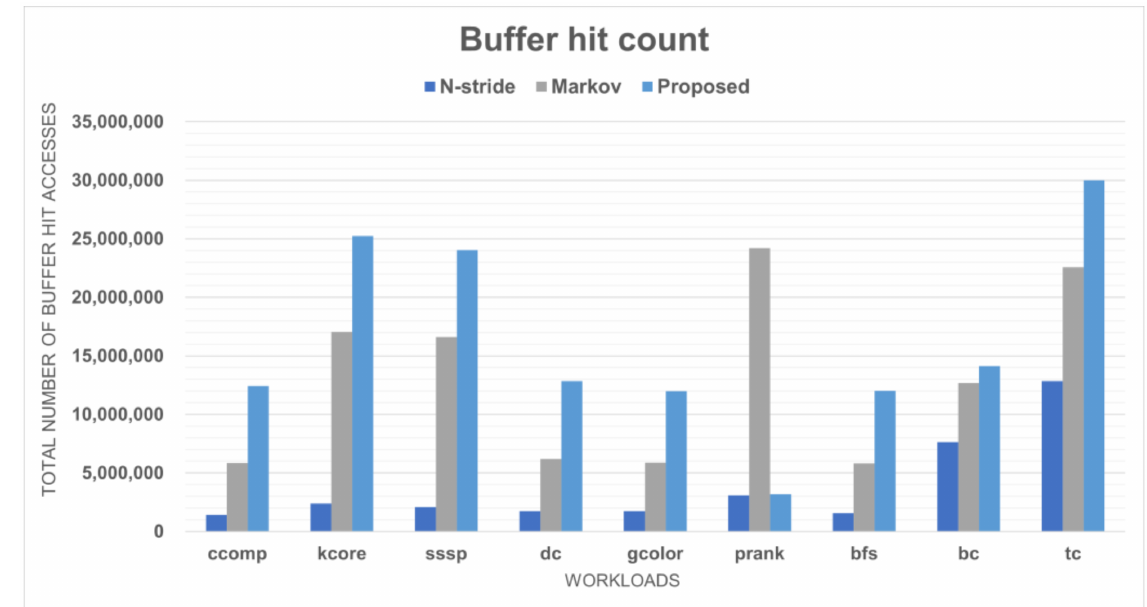
Figure 18. Buffer-hit count of basic